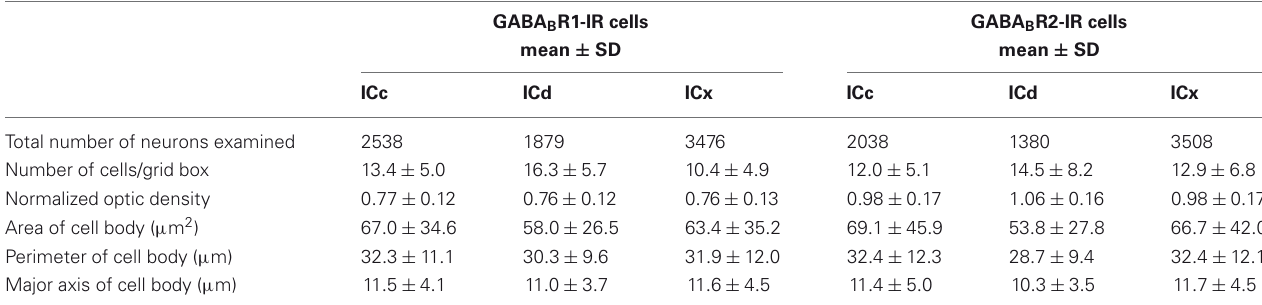
Table 1 | Summary of results from two animals for GABA B R1-IR and GABA B R2-IR cell bodies,